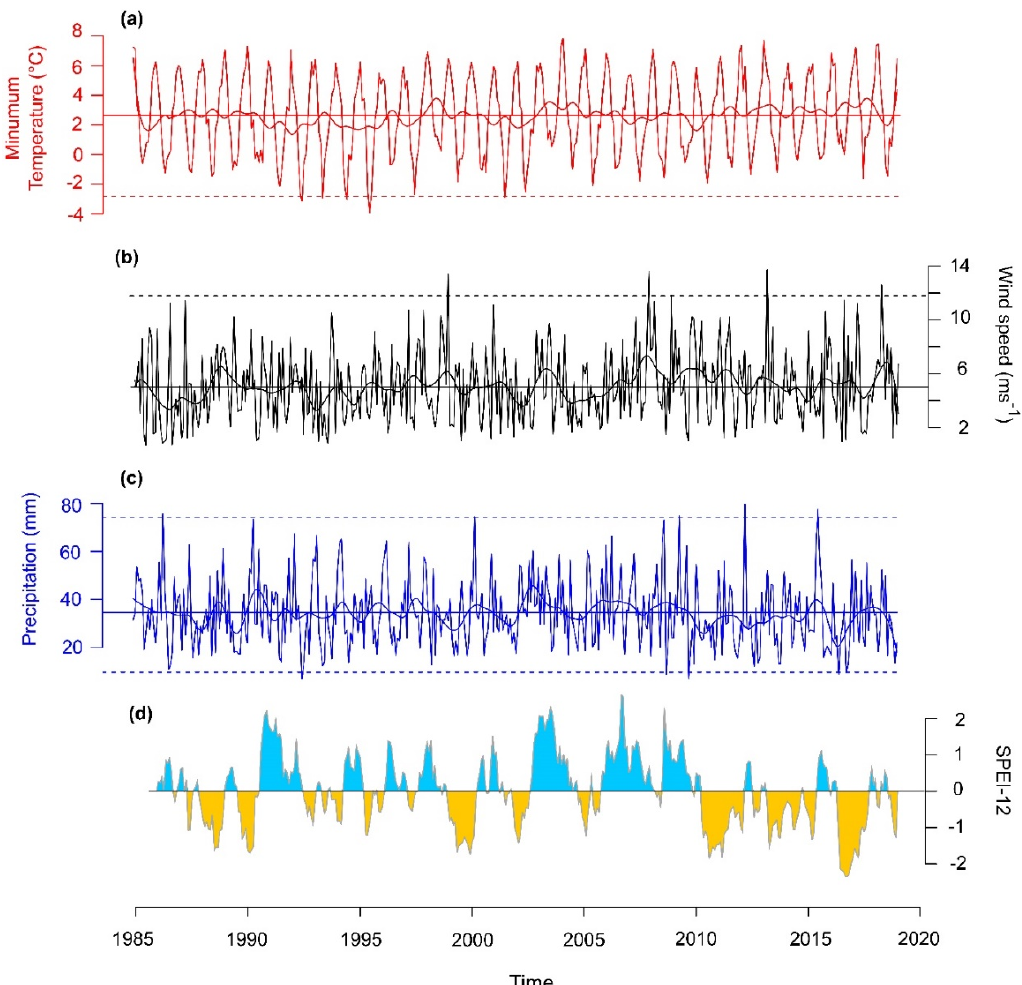
Figure 2. Magellan Region (MR) monthly climate time series (Climatic Research Unit Time-Series (CRU TS) 4.03) from January 1985 to December 2018 for: ( a ) minimum temperature (in ◦ C); ( b ) wind speed (in ms − 1), ( c ) precipitation (in mm), ( d ) standardized precipitation-evapotranspiration index (SPEI). Extreme events (EE) below the 1st percentile and above the 99th percentile are indicated (values surpassing dotted lines). SPEI scale ranges from − 2 (very dry) to + 2 (very wet). Pink (light blue) shaded stripes indicate dry (wet) periods.